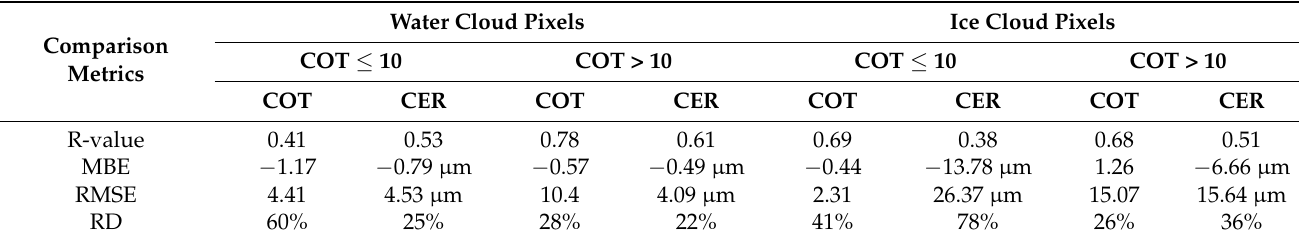
Table 4. Metrics for COT and CER comparisons between MODIS and SGLI for water and ice cloud